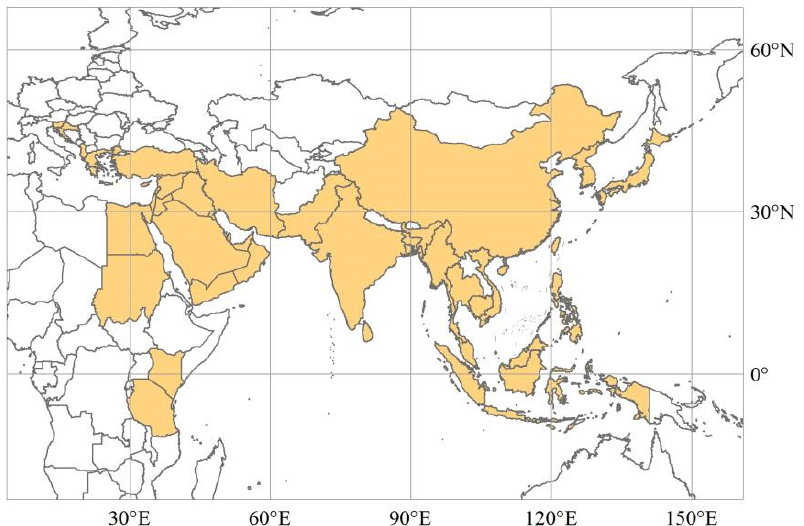
Figure 1. Study area. Note: The map is a drawing is based on the standard map of GS (2016) 1667 that come from the standard map service system of the Ministry of Natural Resources of the People’s Republic of China (http://bzdt.ch.mnr.gov.cn/index.html, accessed on 3 October 2022).